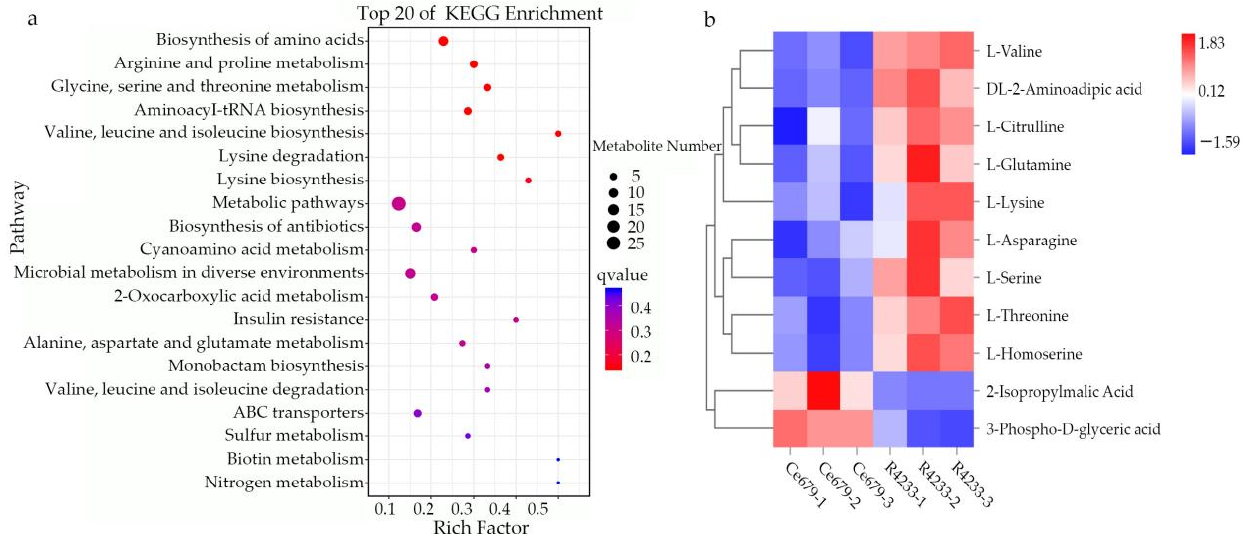
Figure 9. KEGG pathway of DEM and hierarchical clustering analysis. ( a ), KEGG analysis of DEMs; ( b ) hierarchical clustering analysis of DEMs associated with biosynthesis of amino acids (Padj ≤ 0.05, and log 2 FC > 1) in a young panicle.